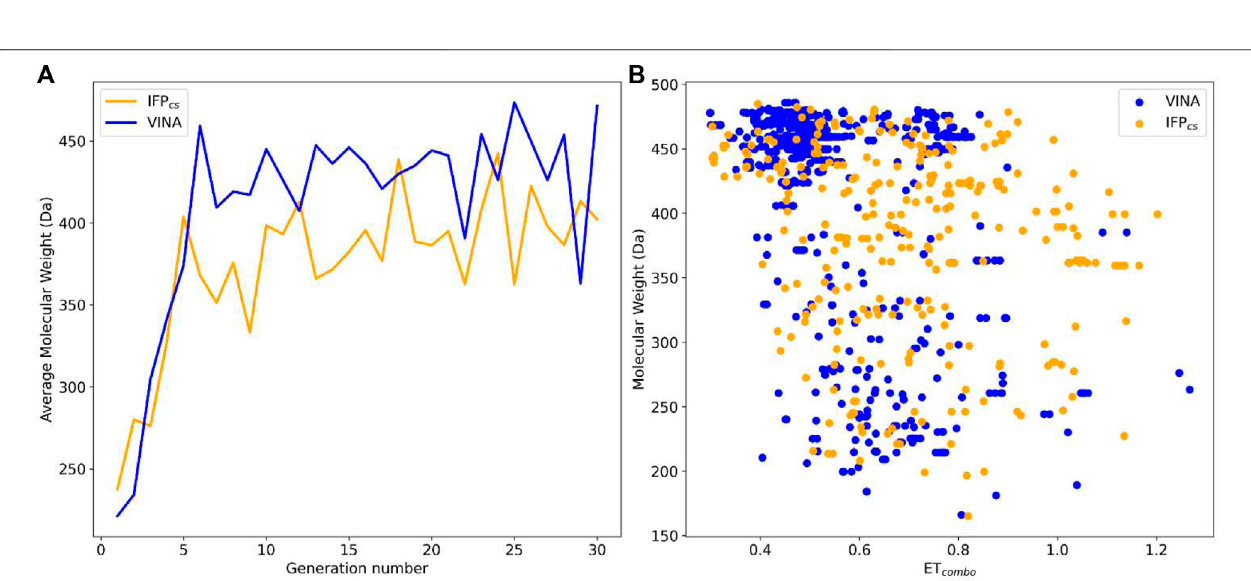
FIGURE 12 | Chemical structure of the seven fragment CK1 δ inhibitors derived from the work of Bolcato et al. (2021).